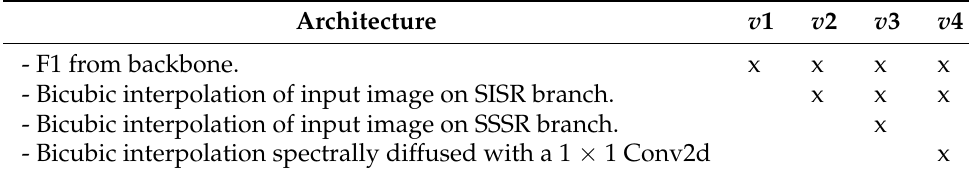
Table 2. Different versions of the dual-network